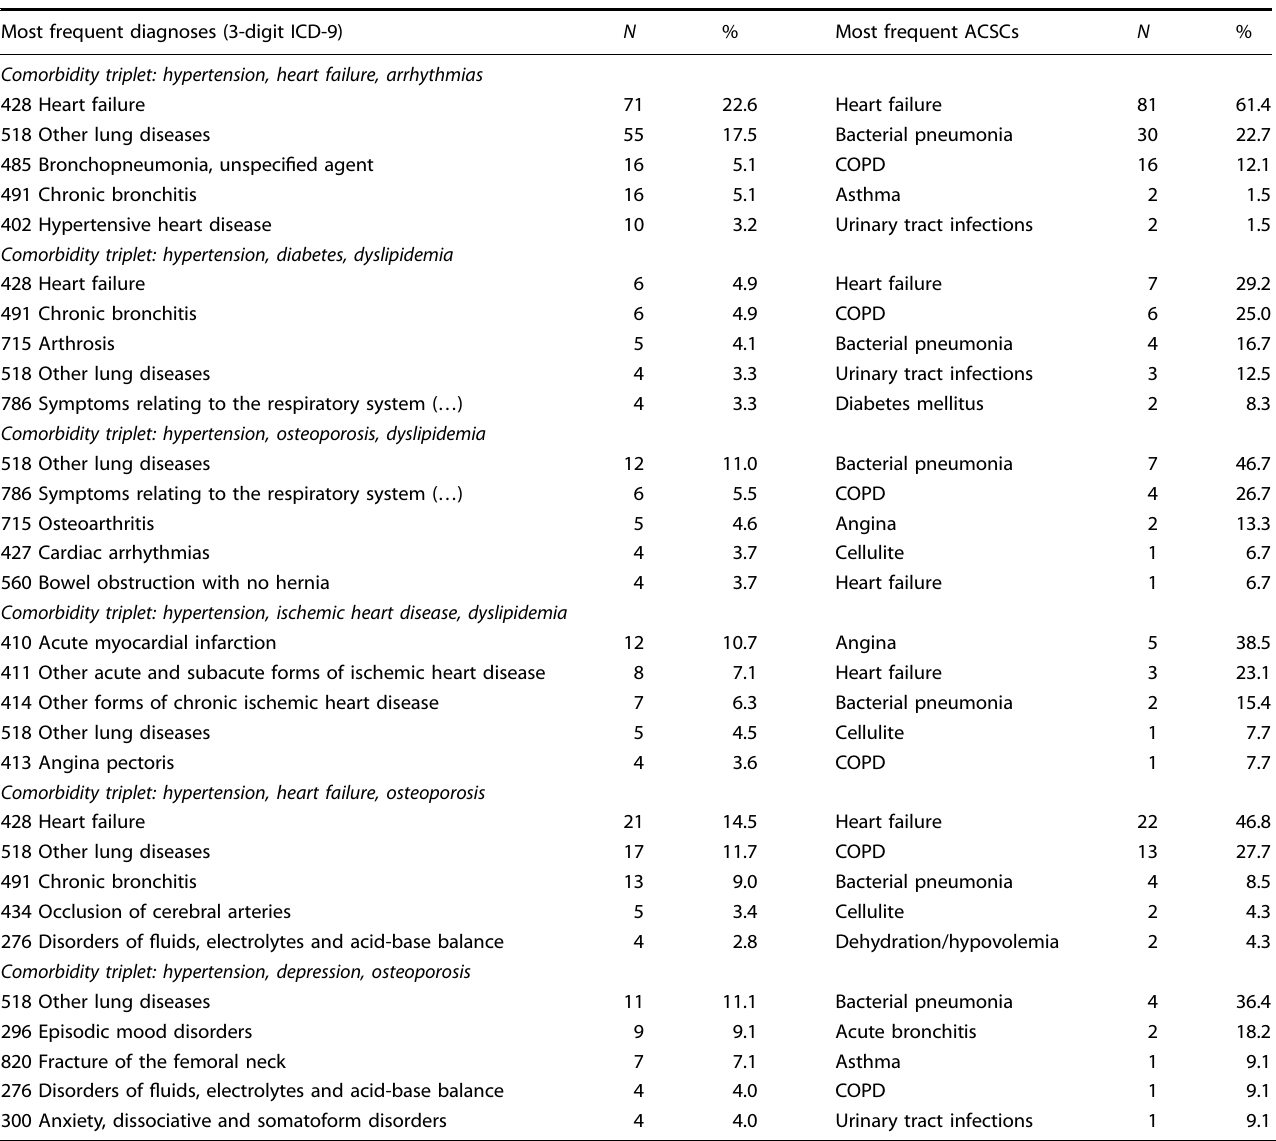
Table 3. Most frequent reasons for total and avoidable hospital admissions for patients with OLD by comorbidity triplets (sets of three different comorbidities) in 2017 – 2018, showing absolute numbers and percentages of total. Most frequent diagnoses (3-digit